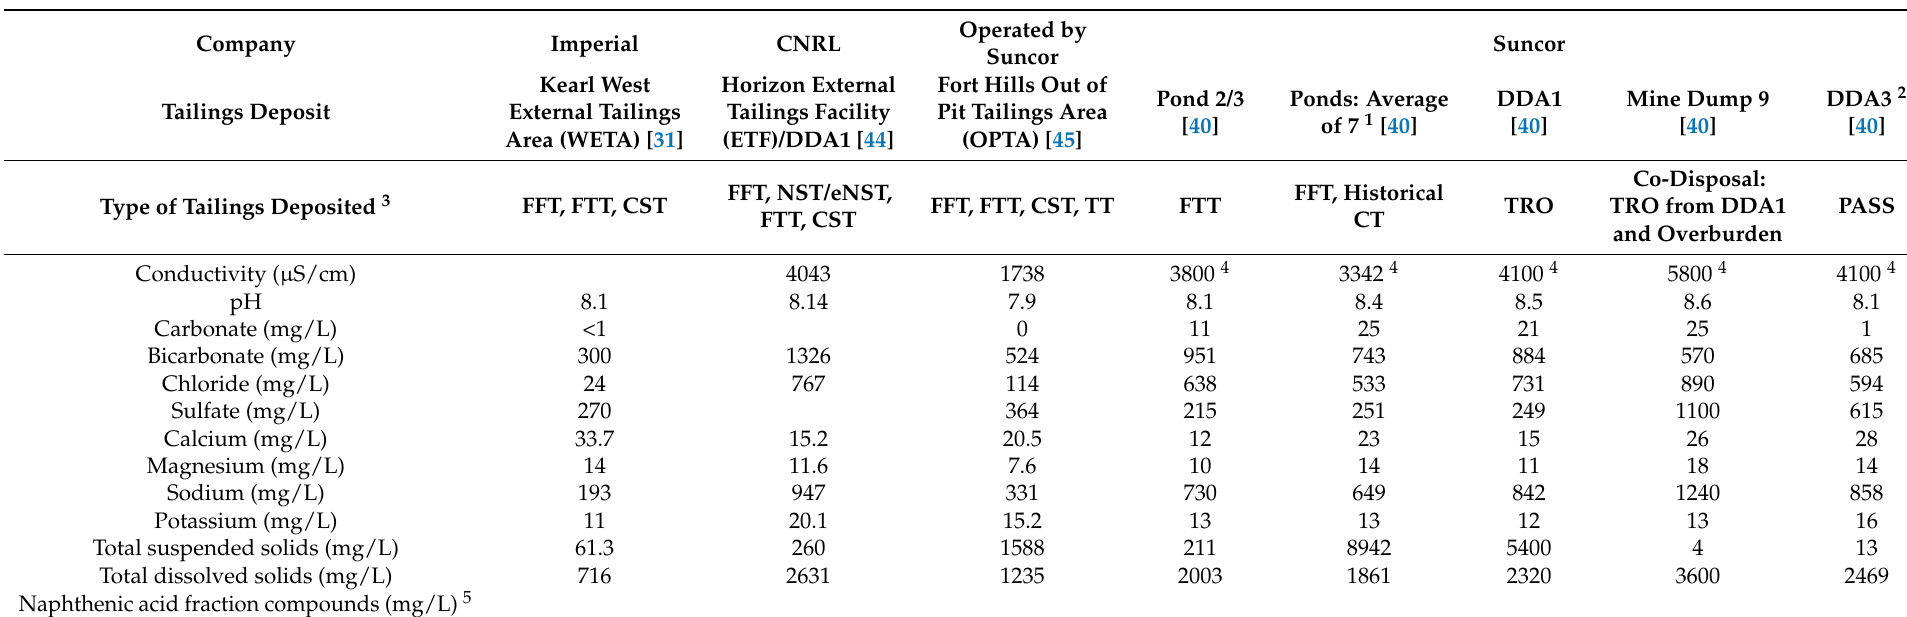
Table 2. Year 2019 surface water chemistry for Imperial, Canadian Natural Resources Ltd. (CNRL), and Suncor oil sands tailings deposits with ponded surface water in Alberta. Tailings deposits include tailings ponds, temporary dedicated disposal areas (DDAs), deep in-pit deposits, and EPLs. Table 3 contains 2019 surface water chemistry for Syncrude tailings deposits and surface water chemistry from the nearby Athabasca River (provided for